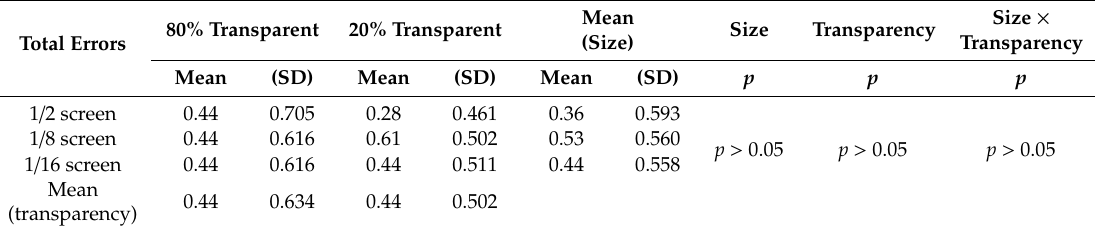
Table 5. Descriptive statistics and two-way ANOVA of total errors.